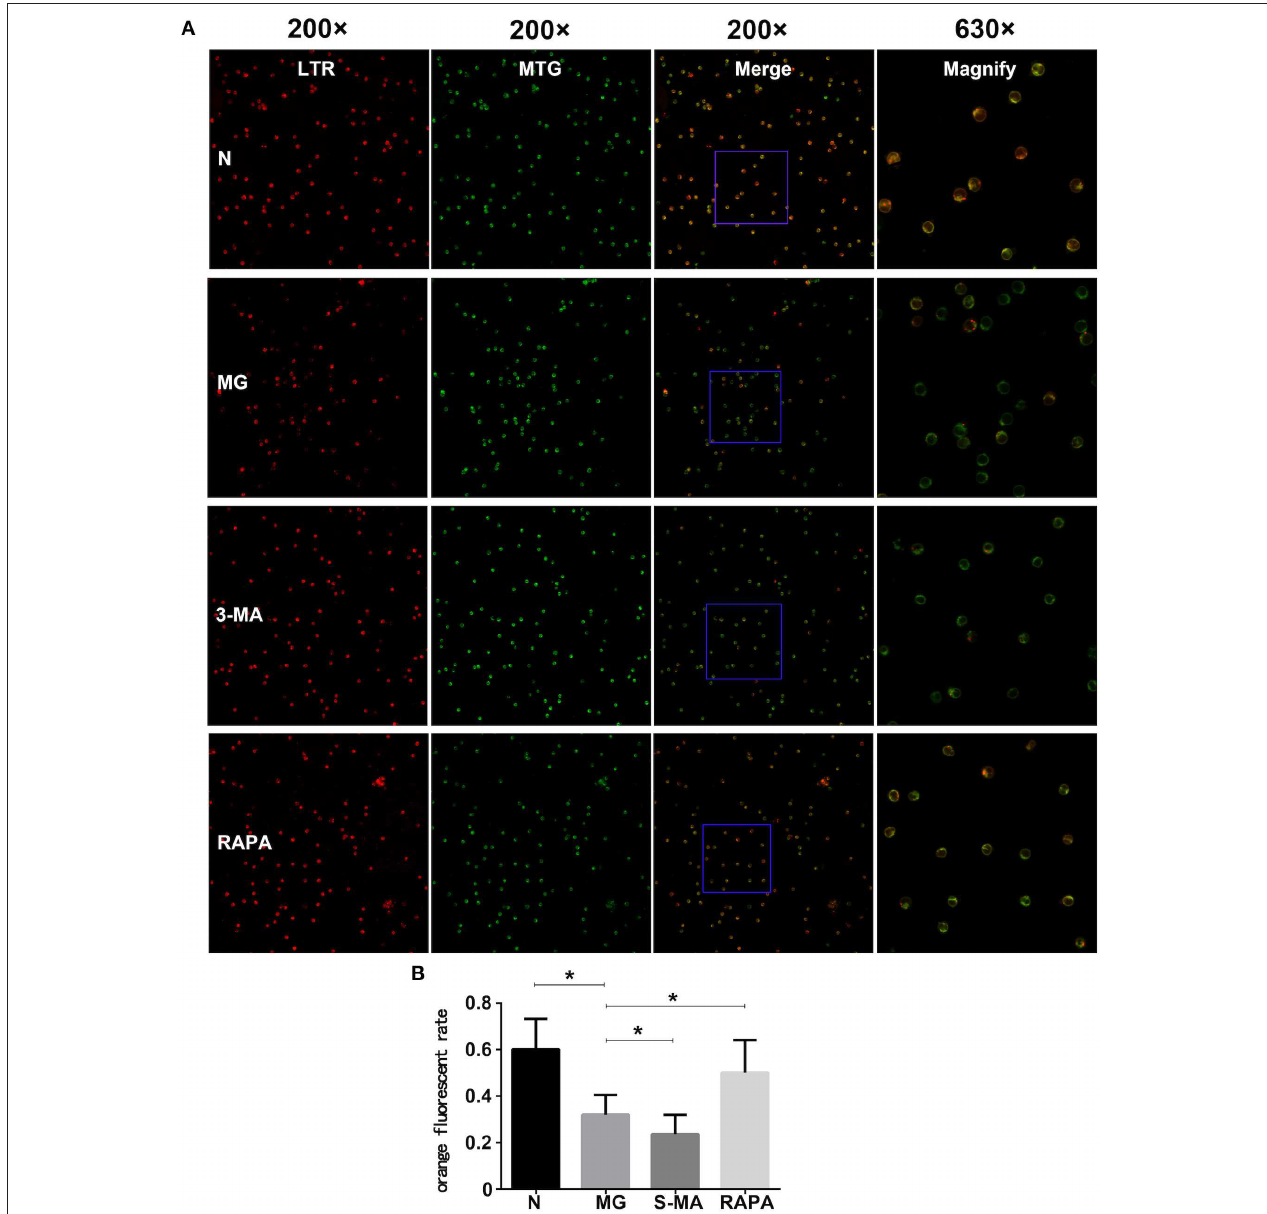
FIGURE 2 | Treg cell fusion of lysosomes and mitochondria. (A) The Treg cells fluorescent pictures of four groups in confocal microscopy. Each group from left to right are fluorescence LTR, MTR, and fusion display (200 × ), as the rightmost fused fluorescent randomly selected partially enlarged (630 × ). (B) Results of the statistical analysis of the four groups (* P <